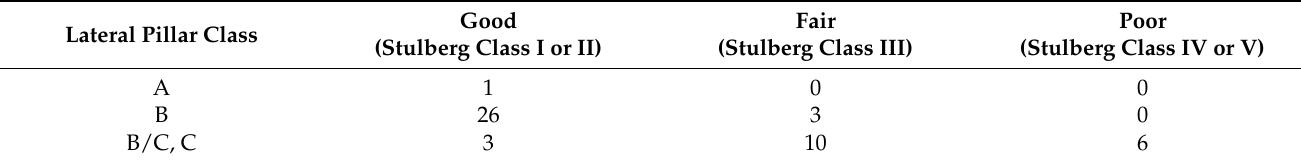
Table 2. Outcome according to the lateral pillar